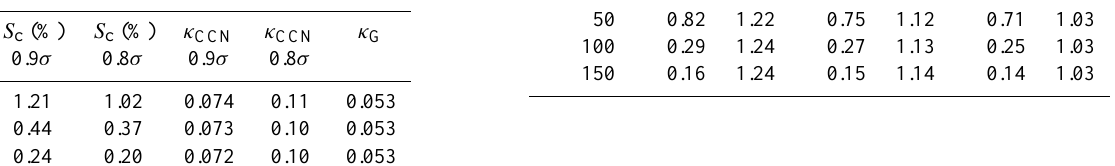
Table 2. Calculated critical supersaturations S c and effective hygro- scopicity parameters κ CCN for an idealized biomass burning parti- cle consisting of 30% levoglucosan and 70% insoluble material at temperature T = 293K, assuming that the surface tension at the point of activation is 0.9 and 0.8 time that of water. κ CCN for the original particle (surface tension of water) is 0.052, see also Table 1. κ G remains at 0.053.